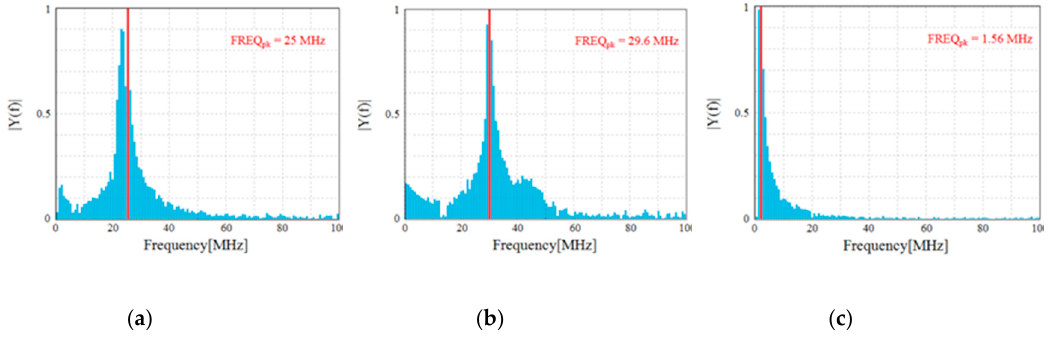
Figure 11. Single PD pulses of ( a ) internal, ( b ) surface, and ( c ) corona discharges.